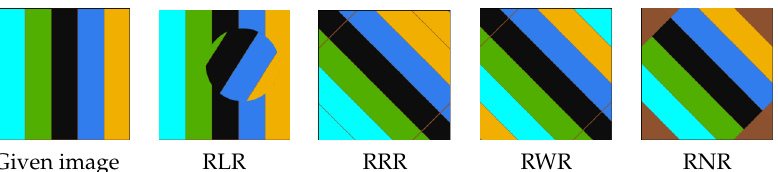
Figure 19. The effect of different rotation methods on the rotated image. The RRR and RWR expanded the central region (i.e., the black stripe) by repeating parts of it. RNR resulted in the loss of image content at the image’s periphery and the creation of artificial pixel values to fill the gap. In contrast, RLR manipulated the content of the image while preserving the information around the image’s periphery well. Table 5. The architectures of the decoders of the MobileNet-based and VGG16-based auto-encoders. Conv2D and Conv2DT represent the 2D convolutional layer and the transposed 2D convolutional layer,